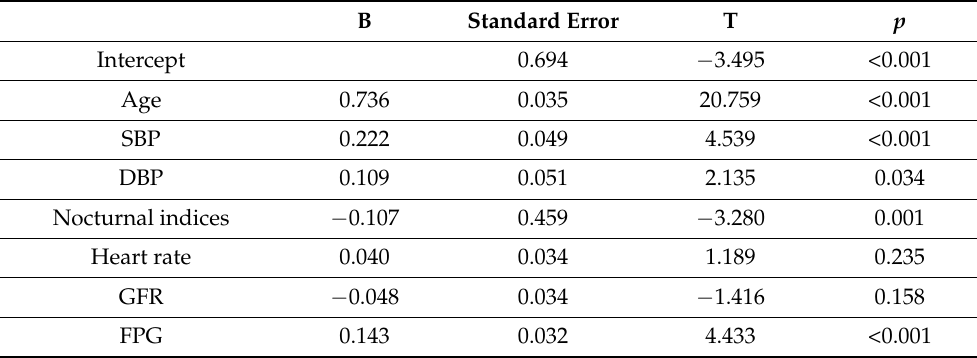
SB p = systolic blood pressure; DB p = diastolic blood pressure; GFR = glomerular filtration rate; FPG = fasting plasma glucose; PWV = pulse wave velocity. All dippers had the lowest average PWV values (8.23 m/s), followed by non-dippers with higher average PWV values (8.87 m/s, p < 0.001). The highest PWV values were measured in all inverse dippers (9.49 m/s, p < 0.001), especially in group C (10.12 m/s). All differences between the examined dipping profiles and hypertension groups are shown in Figure 1.